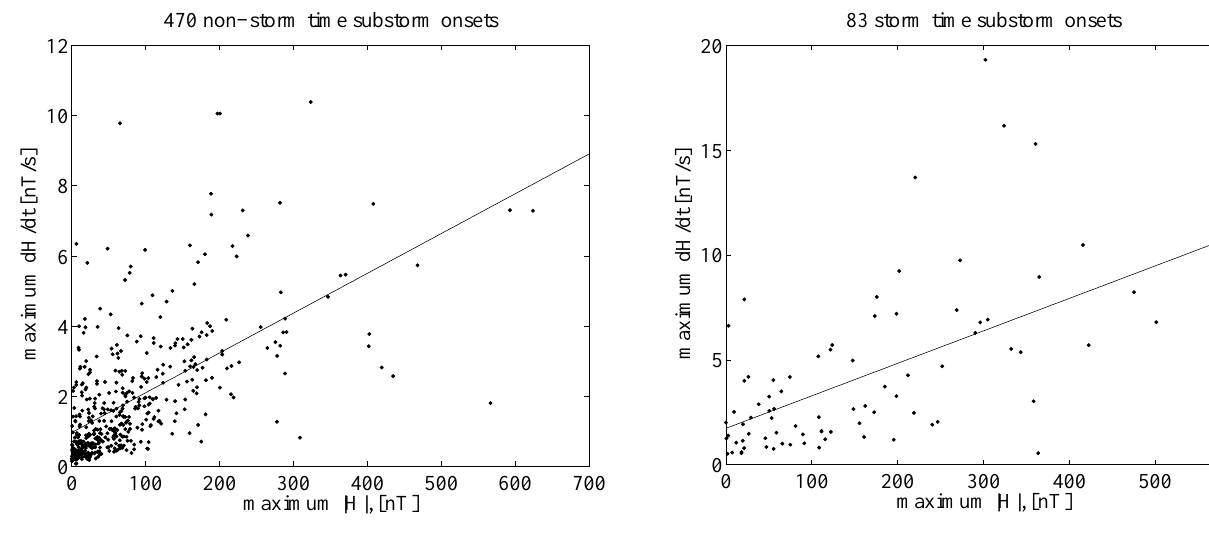
Fig. 8. Plot of | H | against corresponding largest max | d H /dt | for 470 non-storm time substorms. The line is the linear correlation.